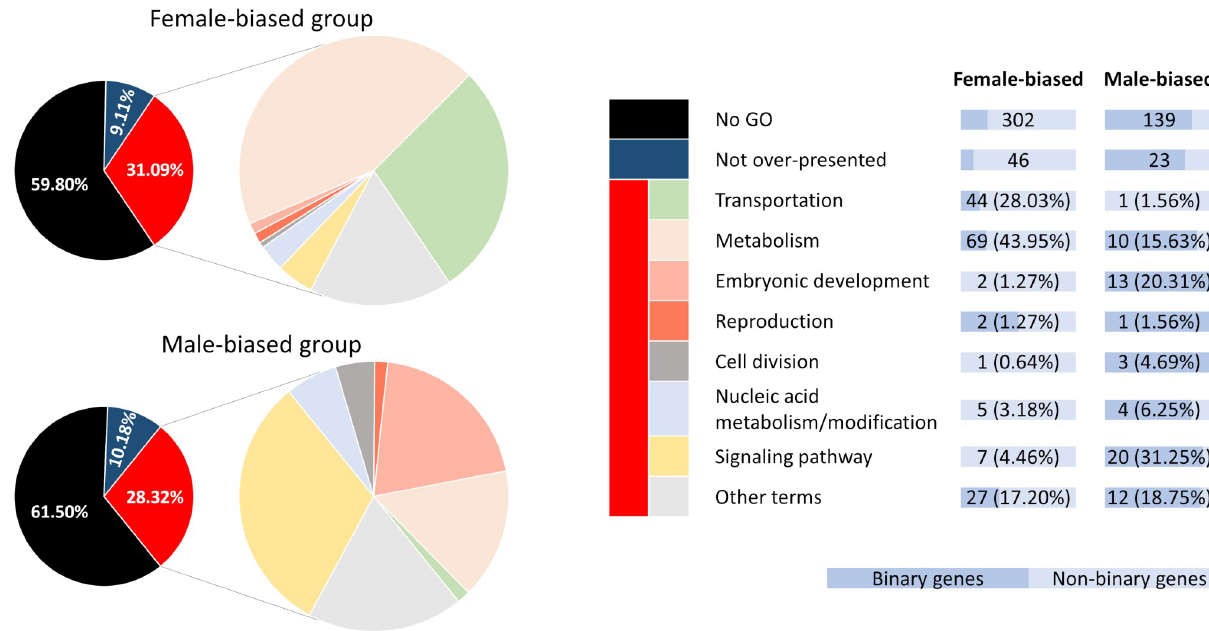
Fig 6. Number of genes assigned to each functional category described in S1 Fig. Aside from genes found to be accounted for over-presence of certain GO terms (red group), the majority from our gene list are not associated with any GO terms (black group) while some other genes did not cause significant enrichment of the terms they are annotated with (dark blue